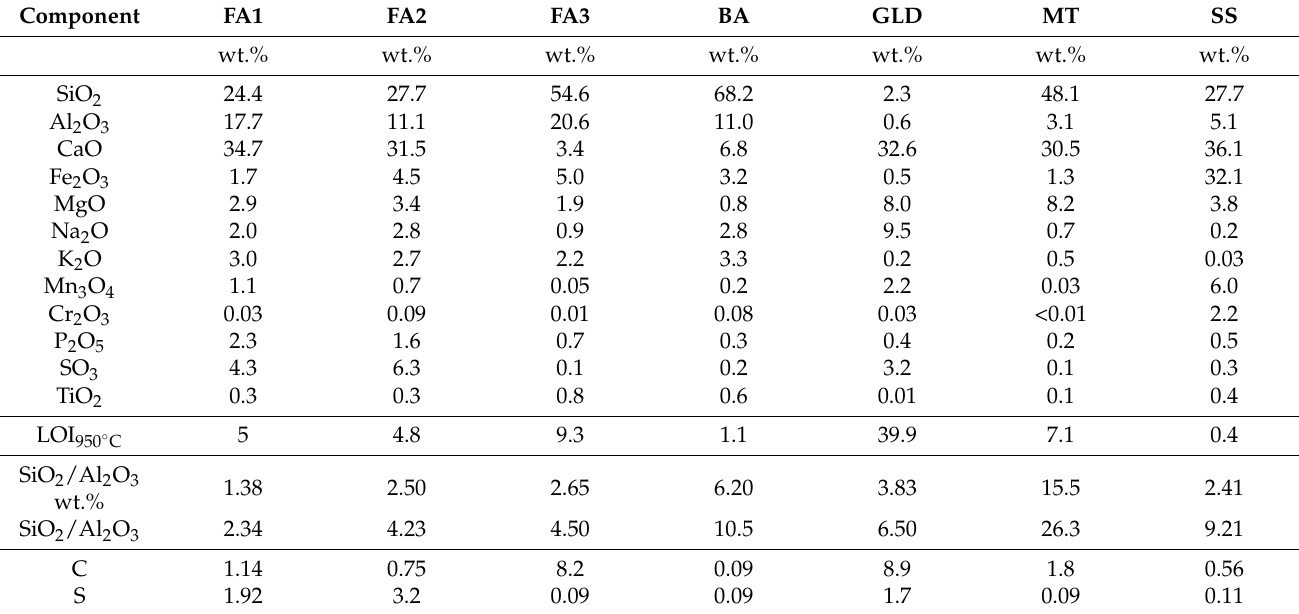
Table 6. Chemical compositions of the samples obtained with XRF analysis; values expressed in wt.%.